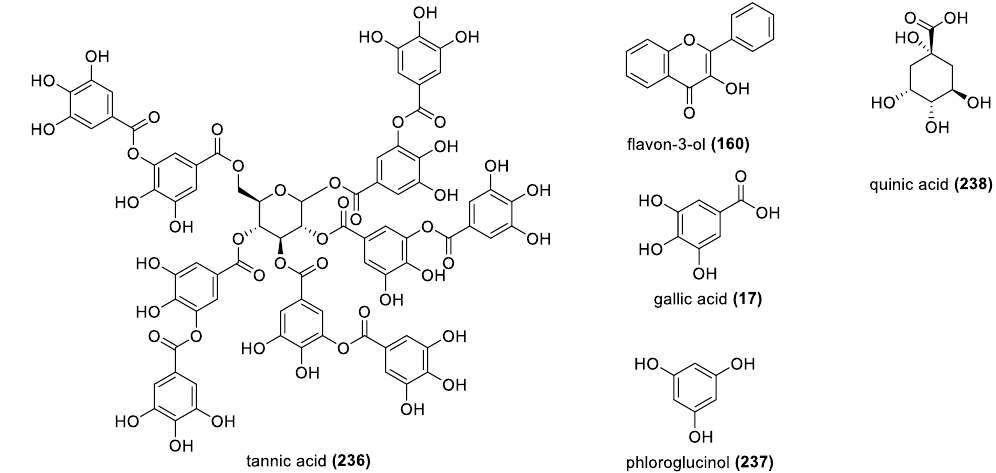
Figure 15. Structure of tannic acid and the most common units that form tannin scaffolds. Due to the high number of phenolic OH groups, tannins are strong antioxidants; 10–30 times more effective than simple phenols or trolox [150]. While smaller antioxidants, especially flavonoids, depend more on the number and location of hydroxyl groups for their activities and favor small substituents, tannins tend to do better with galloyl substitutions. For example, the tannin with the highest antioxidant activity in one assay, the tetrameric ellagitannin sanguiin H-11, has a molecular weight of 952 and is an ellagitannin-based oligomer. This is a generic trend as dimeric and trimeric configurations showed the highest activity for all tannins, and comparisons between larger and smaller compounds showed that only the number of galloyl groups was important. [151]. It was also found that the galloyl group was necessary for tannins to be effective, as even dihydroxyphenol group- based tannins showed no scavenging